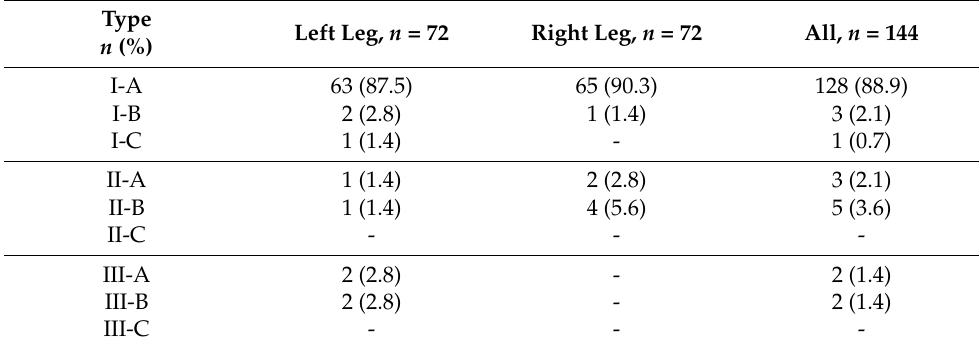
Table 3. Infra-popliteal arterial branching variations of the study sample ( n = 144) were categorized according the classification by Kim et al. [52].